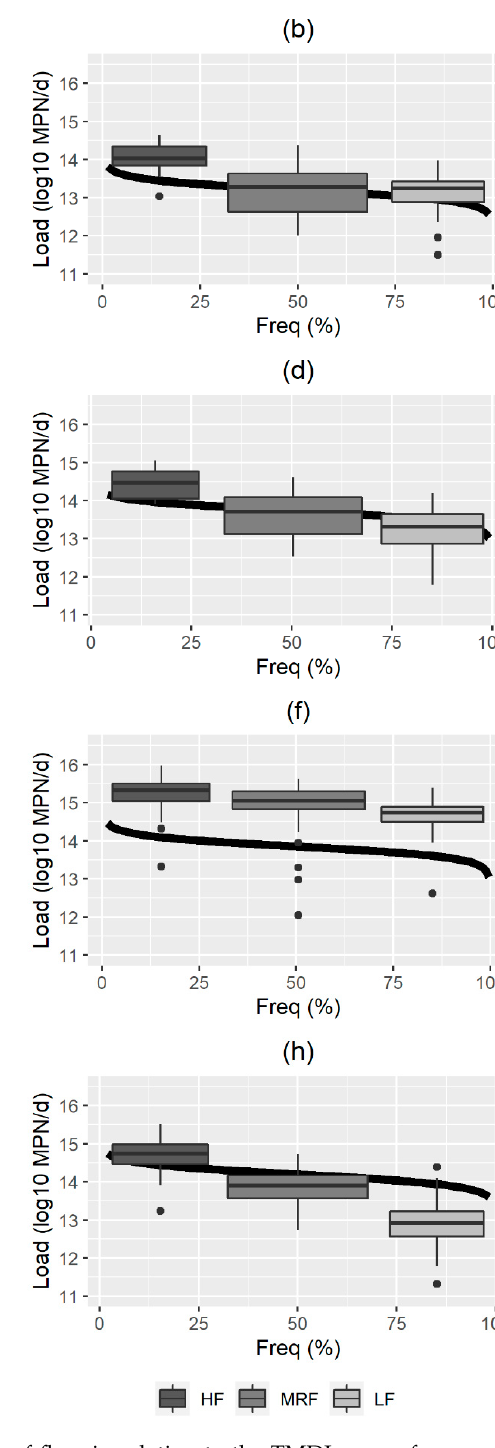
Figure 8. E. coli samples and box-plots per class of flow in relation to the TMDL curve for gauge ( a , b ) 56028000 / RD001, ( c , d ) 56075000 / RD007, ( e , f ) 56110005 / RD013 and ( g , h ) 56539000 / RD023. HF, high flows, MRF, Mid-range flows, LF,